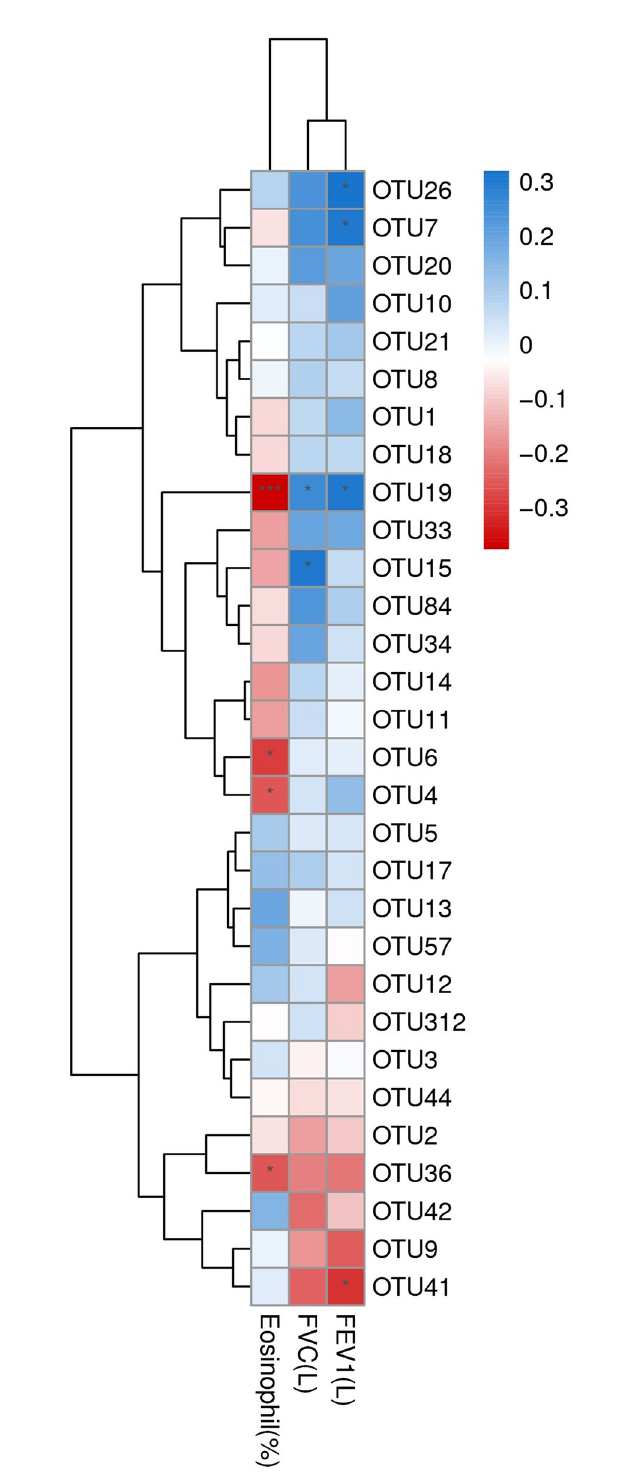
Fig 6. The heatmap analysis of Spearman correlation between OTUs and blood eosinophil percentage and pulmonary function. Spearman correlation coefficient (r) ranges between -1 and 1. r > 0 indicates positive correlation and r < 0 negative correlation. � p = 0.01–0.05, ��� p < 0.001. OTU 26: g__Ruminococcaceae_UCG-002, s__uncultured organism; OTU 7: g__Faecalibacterium, s__Ambiguous taxa; OTU 19: Bacteroides sp.; OTU 15: g__Bacteroides, s__unidentified; OTU 6: Bacteroides sp.; OTU 4: Parabacteroides_merdae; OTU 36: Bacteroides sp.; OTU 41: Fusobacterium sp. IDs of other non-significant OTUs are listed in S1